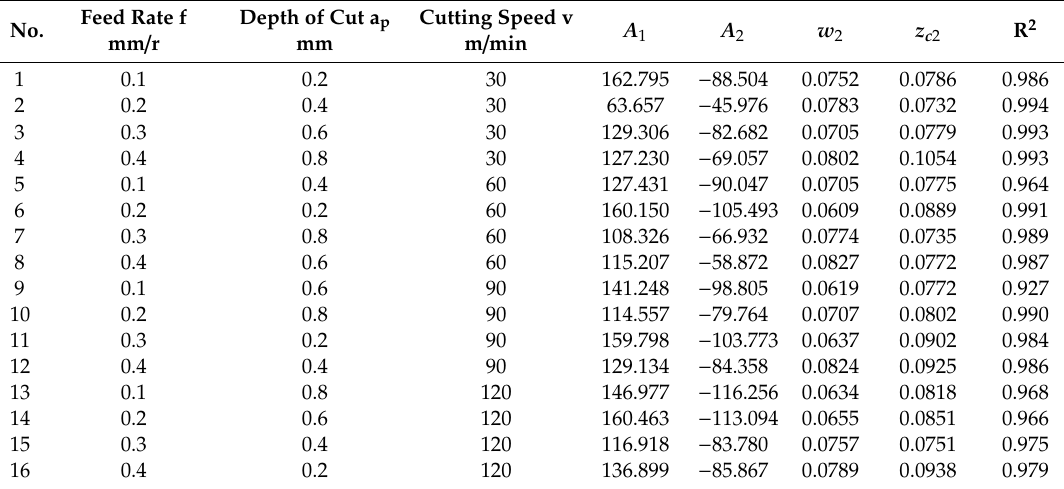
Table 6. Axial residual stresses fitting function coe ffi cients.